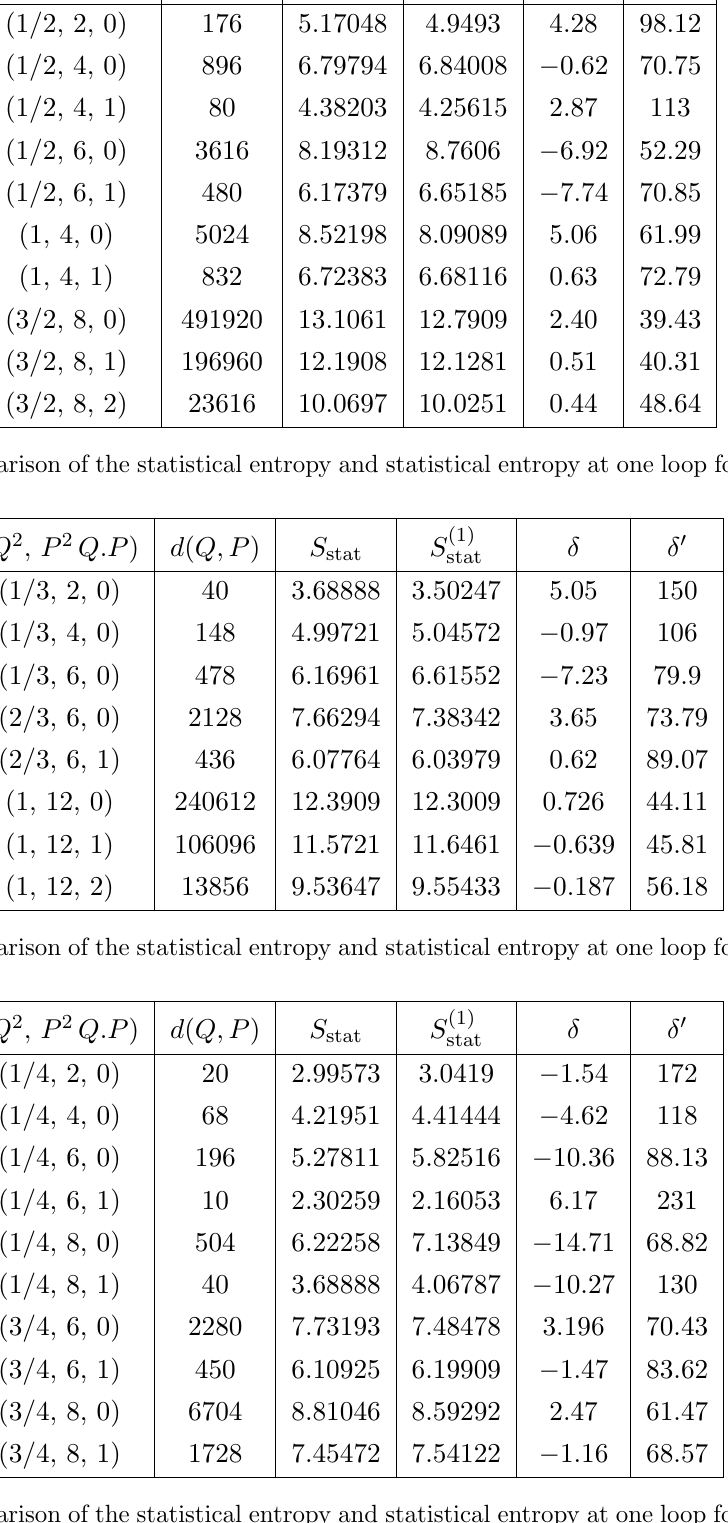
Table 13 . Comparison of the statistical entropy and statistical entropy at one loop for 8A